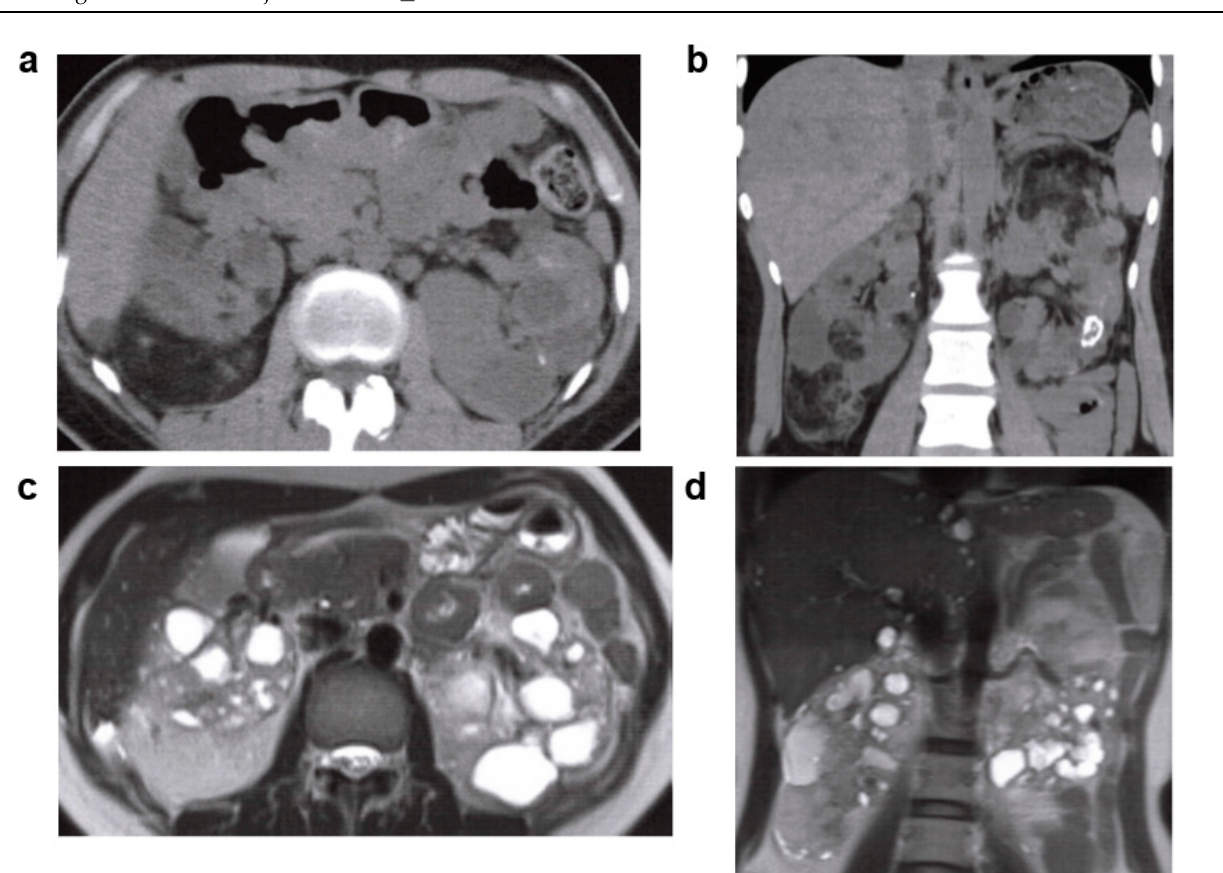
Figure 11. Tuberous sclerosis: 30s, female, wide-ranging loss of heterozygosity noted on the TSC2 gene, no family history of kidney disease, positive for hypopigmented macule/facial angiofibroma/pulmonary lymphangioleiomyomatosis, positive for epilepsy history, kidney function eGFR 55.3 mL/min/1.73 m 2 (image provided by Toranomon Hospital). ( a ) Non-contrast CT image (horizontal section): multiple lipomas and low-density cysts in both kidneys. ( b ) Non-contrast CT image (coronal section): multiple lipomas and low-density cysts in both kidneys. ( c ) MRI T2-weighted image (horizontal section): multiple hyperintense cysts of varying sizes in both kidneys. ( d ) MRI T2-weighted image (coronal section): multiple hyperintense cysts of varying sizes in both kidneys.